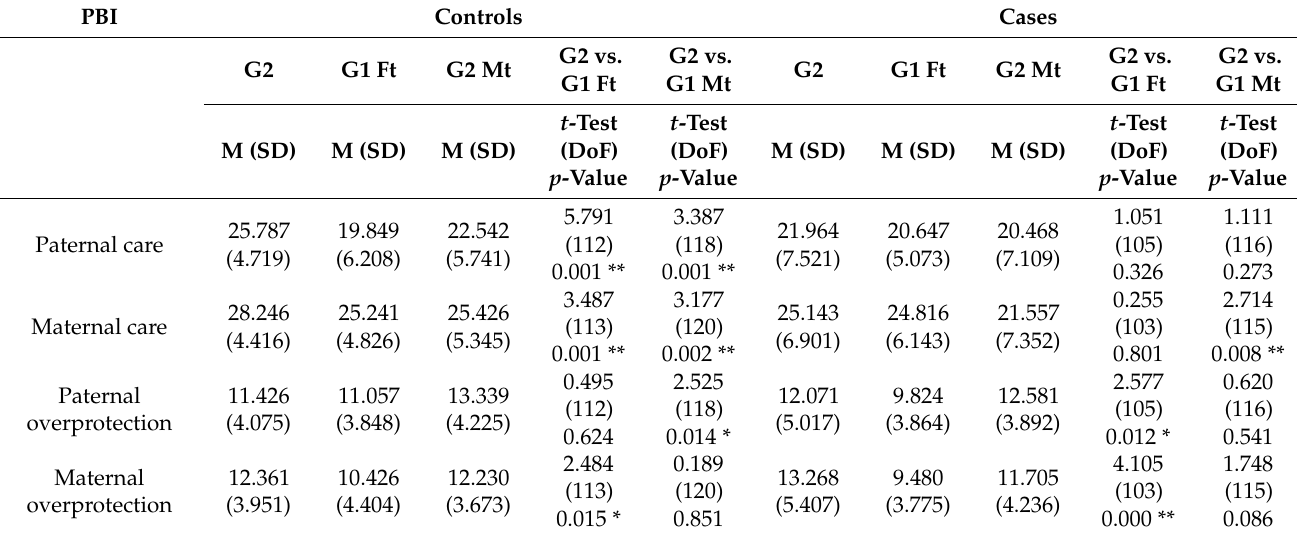
Table 6. The t -test G2 vs.